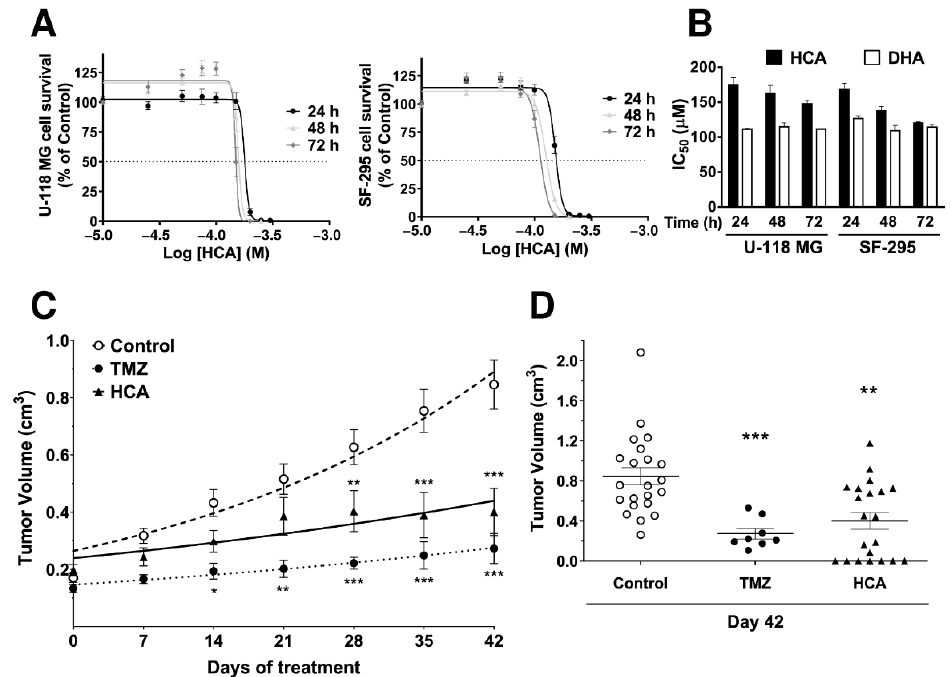
Figure 1. Efficacy of HCA against human glioma. ( A ) Time- and concentration-dependent inhibition of human glioma (U-118 MG and SF-295) cell growth by HCA. ( B ) IC 50 values for HCA and DHA against glioma cell proliferation after a 24, 48, and 72 h treatment (mean ± SEM from 3 independent experiments performed in quadruplet). ( C ) Effects of the vehicle alone (control), HCA (200 mg/kg, p.o., daily), or TMZ (80 mg//kg, p.o., daily) against U-118 MG-derived tumor growth in mice during a 42-day treatment. ( D ) Tumor volumes after a 42-day treatment (mean ± SEM: Control, 22 tumors ( n = 13, 3 males and 10 females). HCA, 21 tumors ( n = 12, 6 males and 6 females); TMZ, 8 tumors ( n = 4, 1 male and 3 females). Student’s t-test: *** p < 0.001, ** p < 0.01, * p < 0.05 with respect to the controls. HCA: 2-hydroxycervonic acid; DHA: docosahexaenoic acid; TMZ: